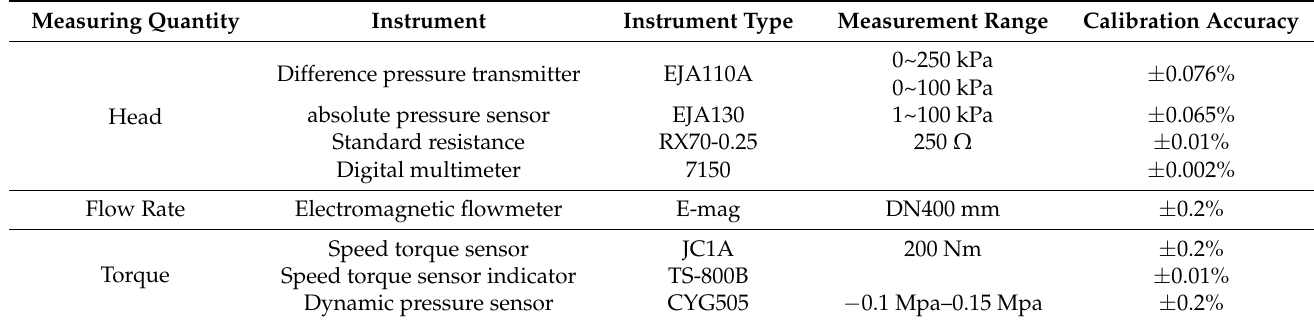
Table 1. Test equipment and related